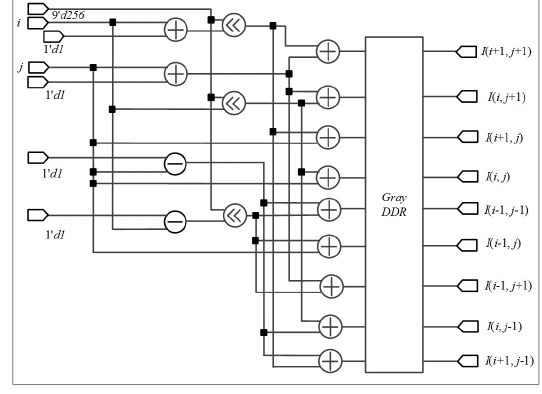
Figure 8. FPGA-based reading DDR memory